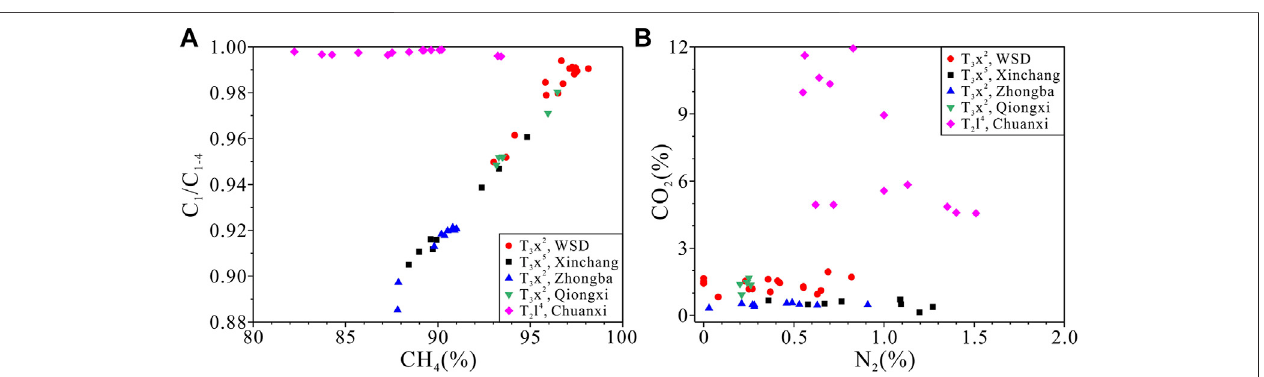
FIGURE3| Thecross-plotsofC 1 /C 1-4 versusCH 4 % (A) andCO 2 %versusN 2 % (B) .TheT 3 x 2 gasesofZhongbaandQiongxigas fi elds(Daietal.,2012b),T 3 x 5 gas from theXinchanggas fi eld(Wuet al., 2016),and T 2 l 4 gas from the Chuanxi gas fi eld (Wuet al.,2020b) are also plotted for comparative analysisand hereafter the same.